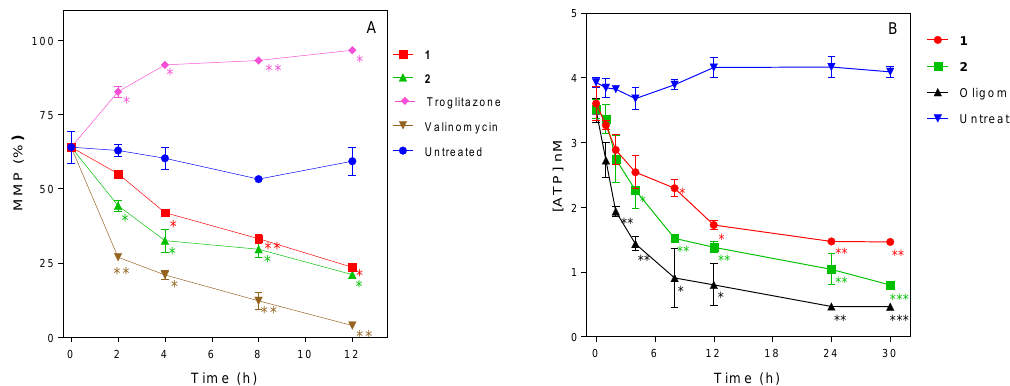
Figure 7. Effects of 3-aminosteroids 1 and 2 on mitochondrial membrane potential ( A ) and intracellular ATP level ( B ) of Tbb 427WT, each at 2 × EC 50 concentration. * p < 0.05; ** p < 0.01; *** p < 0.001 indicate significant difference from the corresponding untreated control at the same time point (unpaired Student’s t -test (n = 3)); error bars = ± SD.